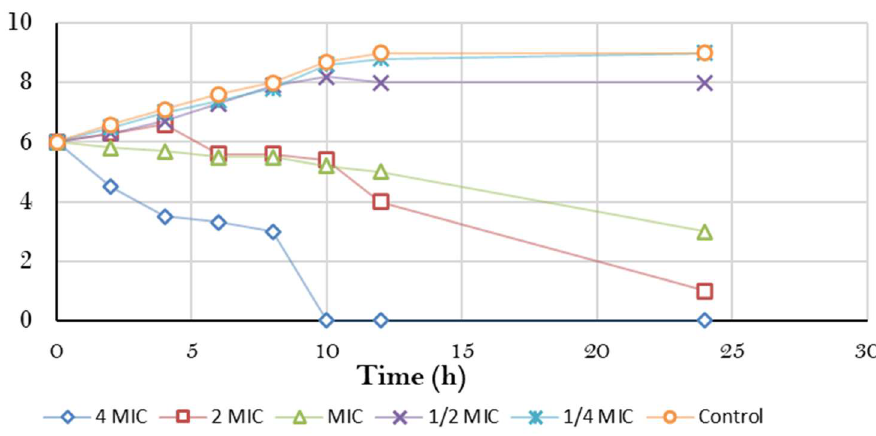
Figure 4. Time-kill curve of V. damsela by M. arboreus extract.